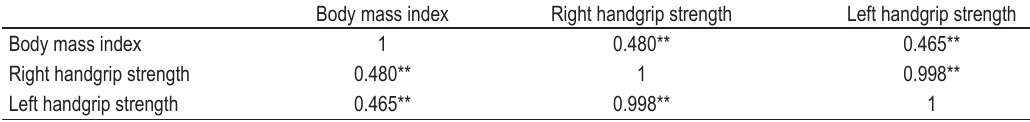
TABLE 3. Pearson correlation of body mass index and handgrip strength of the